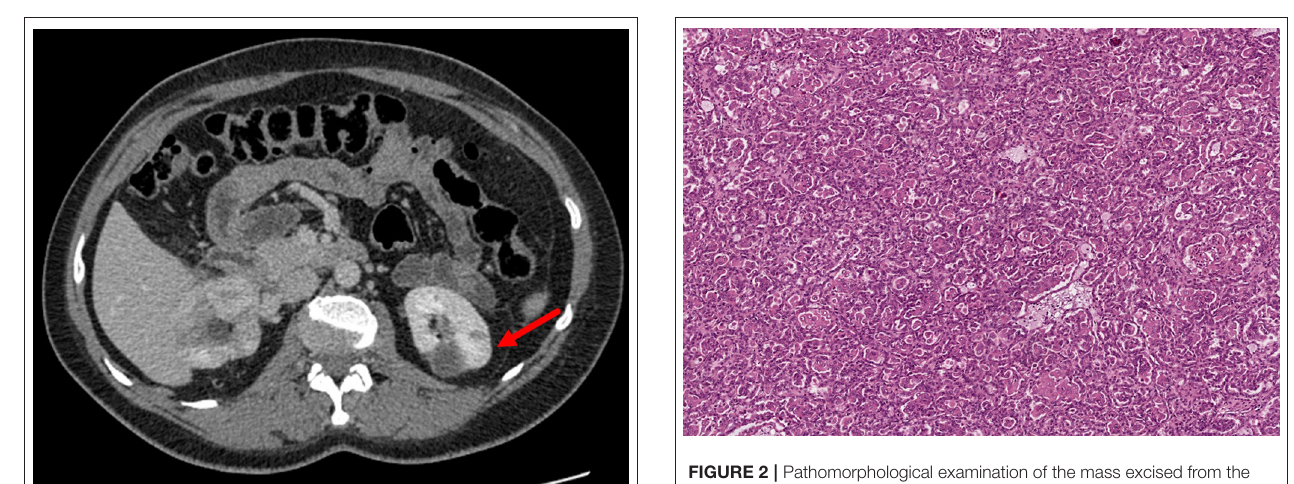
FIGURE 2 | Pathomorphological examination of the mass excised from the right kidney of patient K. Type I papillary RCC. Hematoxylin–eosin staining, magnification ×